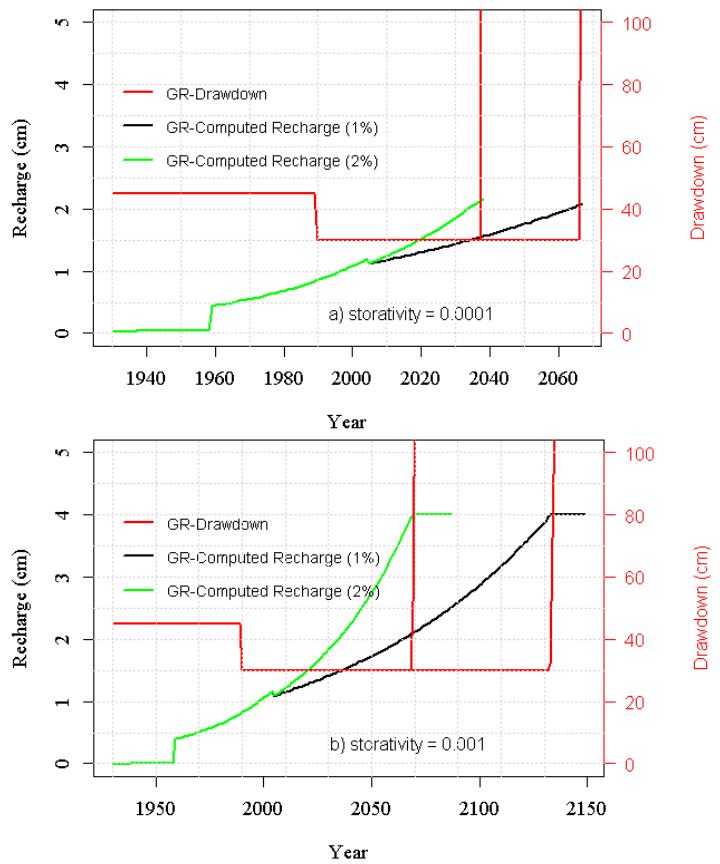
Figure 5. Simulation results of estimated recharge to Grand Ronde and applied drawdown values (cm).